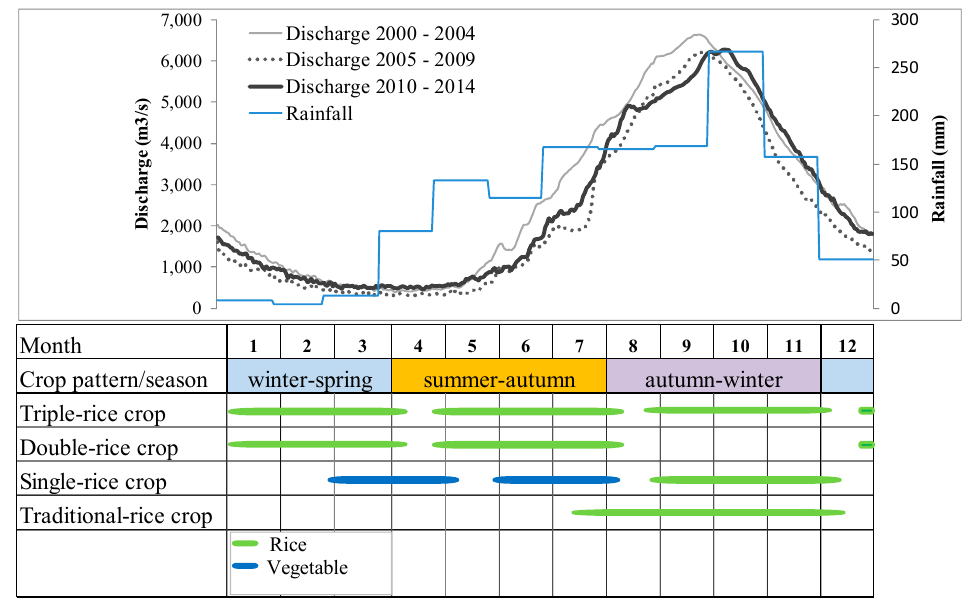
Figure 2. Average monthly discharge at Chau Doc station in Bassac River, between 2000 and 2014, and average monthly rainfall, and crop calendar. Discharge and rainfall data were obtained from the Southern Regional Hydro-meteorological Center (SRHMC), Vietnam.